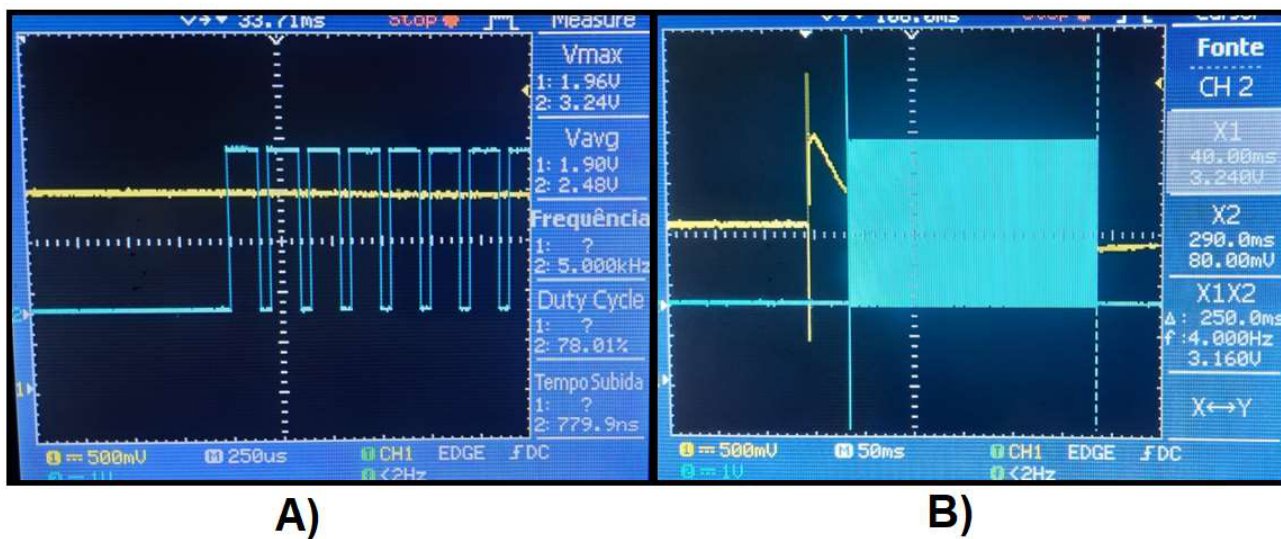
Figure 19. ( A ) Demonstration of a PWM-generated stimulus signal with an average voltage of 2.48 V and ( B ) demonstration of a PWM-generated stimulus signal with a duration of 250 ms.